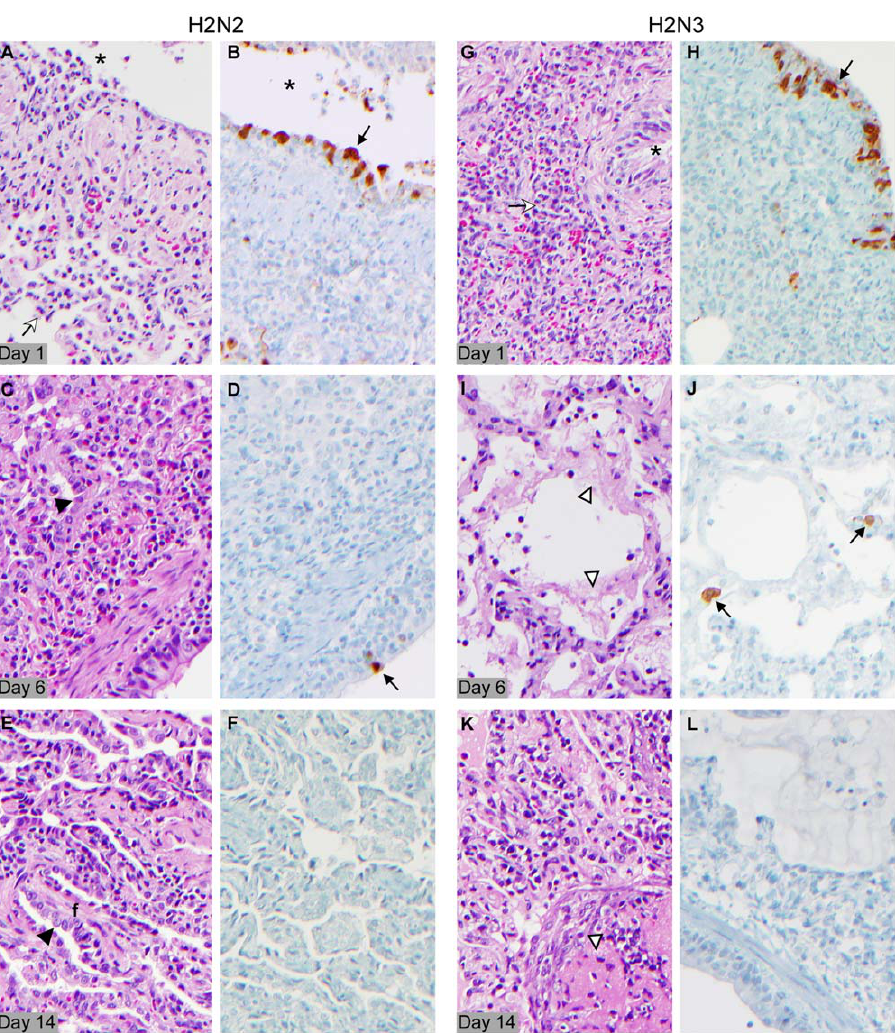
Figure 3. Histopathology of lung lesions. Histopathology was performed on samples derived from human H2N2 and swine H2N3 infected animals on 1, 6 and 14 dpi. The left hand columns (panels A, C, E, G, I, K) are H&E stained sections of lung representative of the three time points. The right hand columns are IHC stained lung sections from the same animal and lung lobe as the H&E stained sections. (A) Inflammatory cells (neutrophils and macrophages) and cell debris in a bronchial lumen (asterisk); similar cell population in adjacent alveoli (white arrow). (B) Antibody positive staining in cells of the bronchial lining epithelium with epithelial cell morphology (arrow). Asterisk indicates bronchial lumen. (C) Alveolar type II pneumocyte hyperplasia (black arrowhead) and fibrin in alveoli adjacent to a bronchus. (D) Rare antibody stained cell in bronchial lining epithelium (arrow). (E) Chronic pneumonia (fibroblasts, lymphocytes, plasma cells) with alveolar septal fibrosis (f) and type II pneumocyte hyperplasia (black arrowhead). (F) Absence of antibody staining. (G) Numerous neutrophils and macrophages within alveoli adjacent to a bronchus (white arrow). Asterisk indicates bronchial lumen. (H) Antibody positive stained cells in bronchial lining epithelium (arrow). (I) Fibrin hyaline membrane (open arrowhead); mixed inflammatory cells and thickened alveolar septae. (J) Rare antibody stained cells with macrophage or possible type II pneumocyte morphology (arrow). (K) Chronic pneumonia (fibroblasts, lymphocytes, plasma cells) and organized fibrin (open arrowhead) within alveoli. (L) Absence of antibody stained cells. Key: A, B=animal 635; C, D=animal 479; E, F=animal 358; G. H=animal 805; I, J=937; K, L animal 745 (for animal numbers see also Table 1).